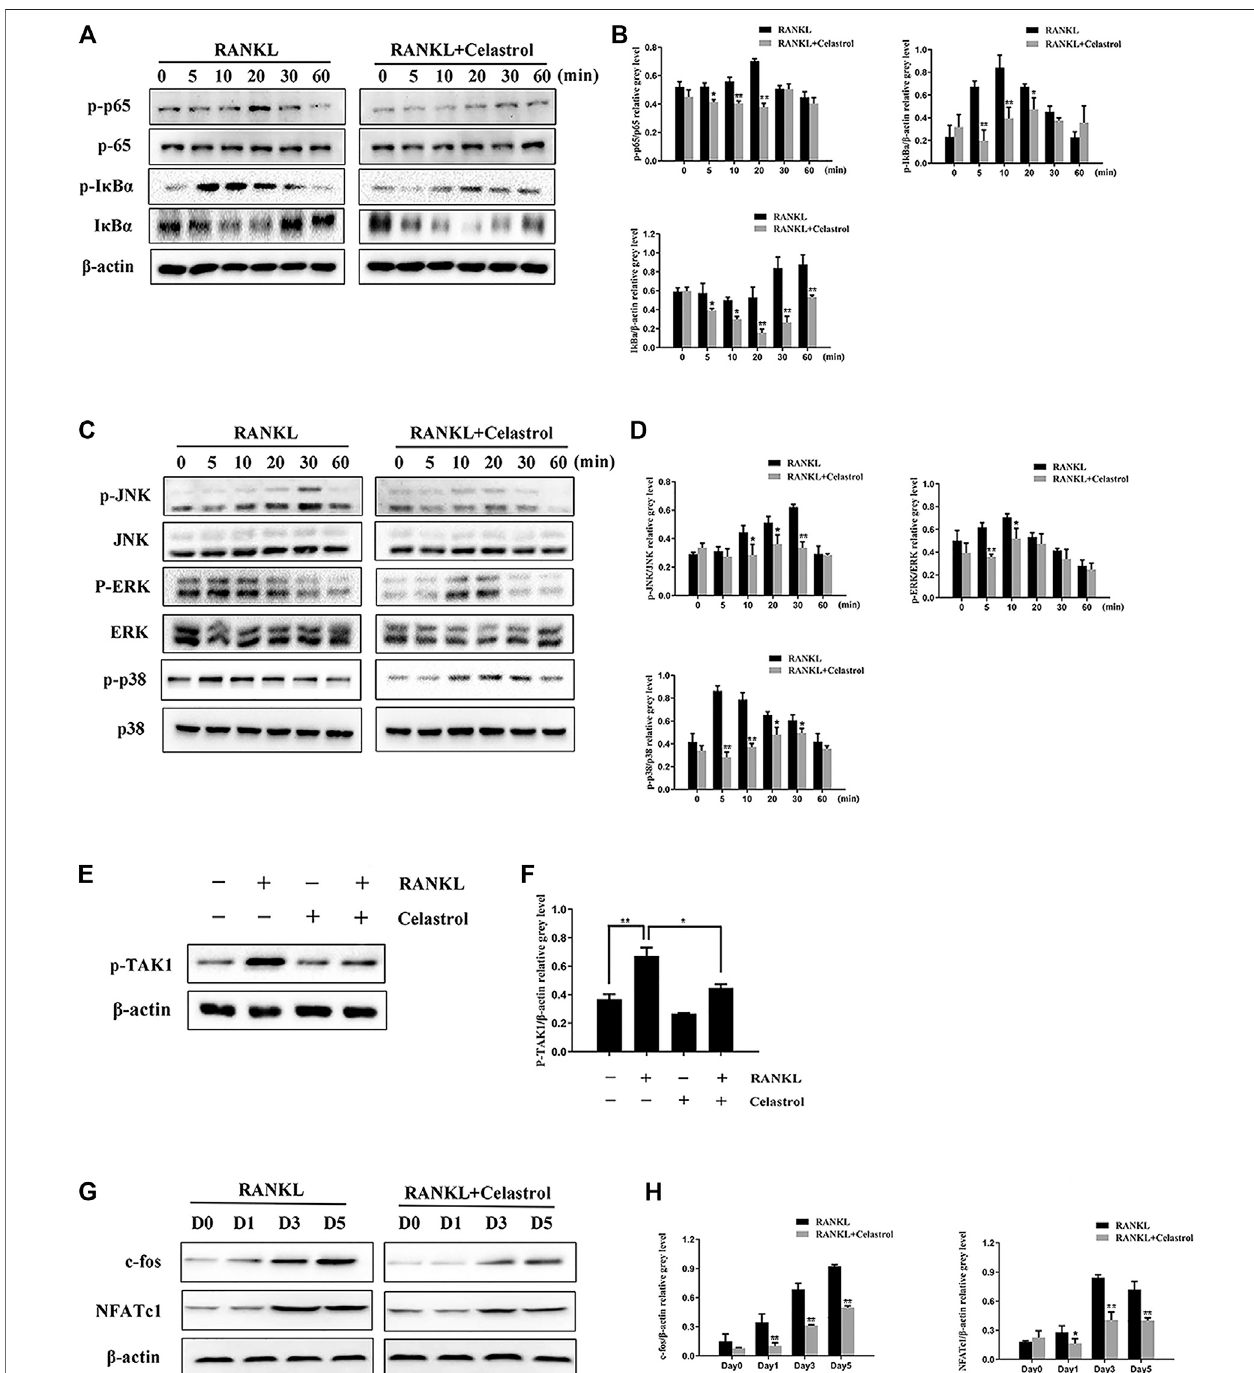
FIGURE 4 | Celastrol supressed RANKL-induced activation of the TAK1-mediated NF- κ B and MAPK signaling pathways. RAW264.7 cells pretreated with 50 nM celastrol or without pretreatment were stimulated with 50 ng/ml: RANKL for 0, 5, 10, 20, 30, and 60 min. The relative levels of protein phosphorylation were determined using western blot. (A – B) Celastrol blocked the RANKL-induced expression of the NF- κ B pathway by inhibiting P65 and I κ B α proteins. (C – D) Celastrol inhibited the phosphorylation of factors in the MAPK pathways of osteoclast formation, including ERK, JNK, and P38. (E – F) We also studied the upstream mechanism of the NF- κ BpathwayandfoundthatcelastrolinhibitedTAK1proteinphosphorylation. (G) RAW264.7cellswereincubatedin50 ng/mlRANKLwithorwithout50 nMcelastrol for 0, 1, 3, or 5 days, respectively. The protein expression levels of c-fos and NFATc1 were detected by western blot. (H) The protein expression of c-fos and NFATc1 was substantially lower in the celastrol-treated group than in the RANKL-induced group after 1, 3, or 5 days, respectively. All experiments were carried out three times, and all data are showed as the means ± SD; * p < 0.05, ** p < 0.01.